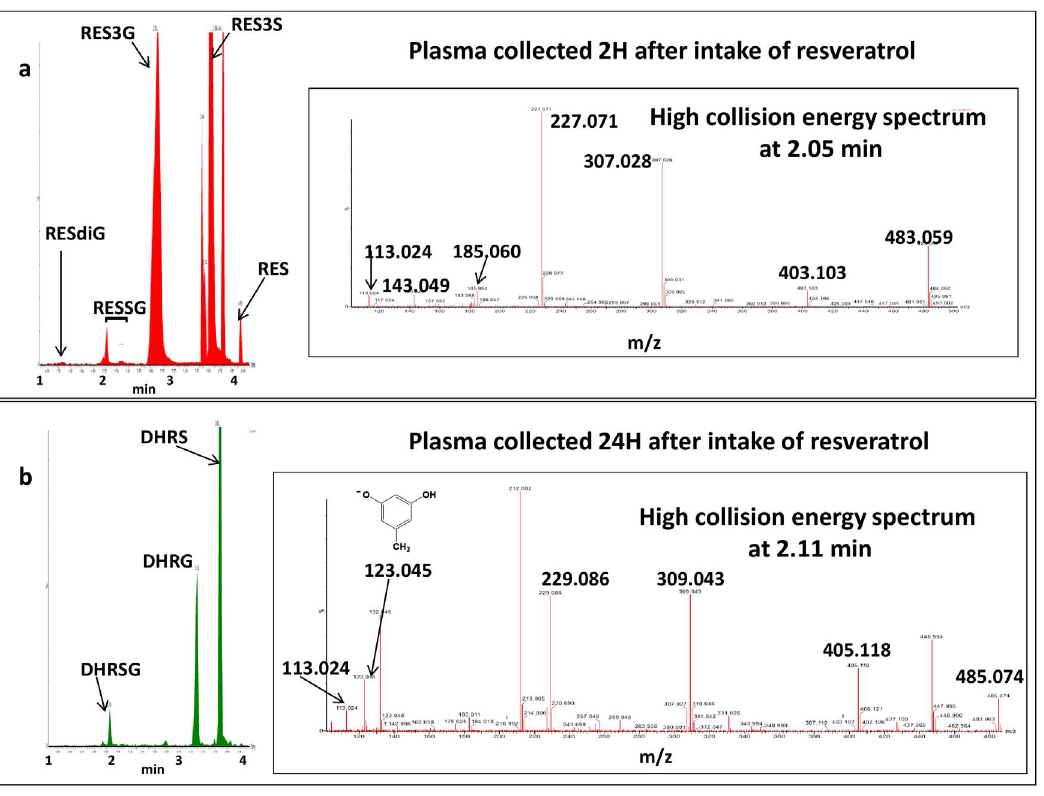
Figure 4. Chromatograms: variations in the intensity of m/z 227.07 (a) and m/z 229.087 (b) vs. time. a : Time 2 h after intake of resveratrol. High-collision energy spectrum at 2.05 min. b : Time 24 h after intake of resveratrol. High-collision energy spectrum at 2.11 min.